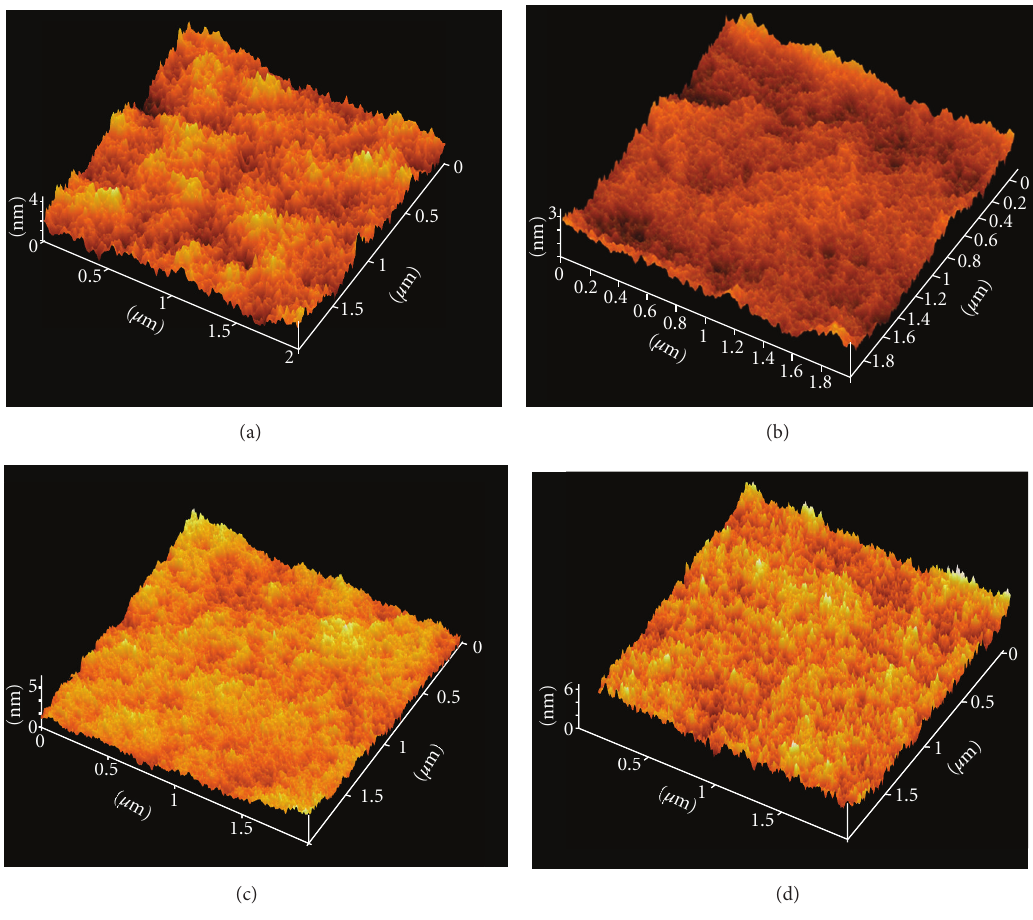
F 4: Surface morphology of PCDTBT:PC